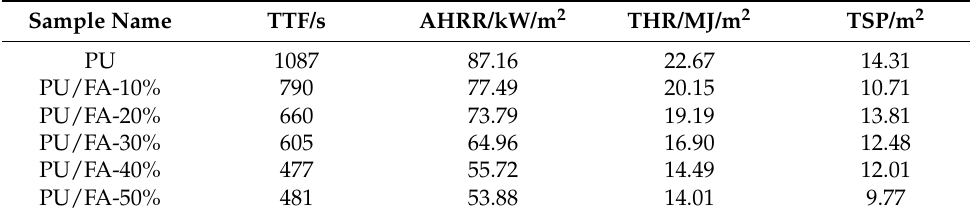
Figure 11. Combustion performance of PU and PU/FA composites. ( a ) HRR curve; ( b ) THR curve; ( c ) SPR curve; and ( d ) TSP curve. Table 3. Cone test data of PU and PU/FA composites.